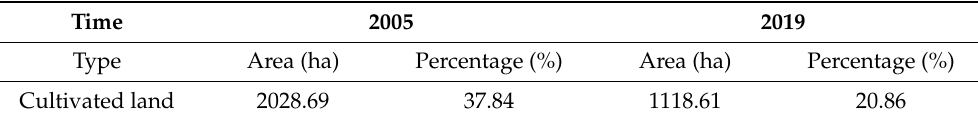
Table 3. Analysis of land use changes from 2005 to 2019.